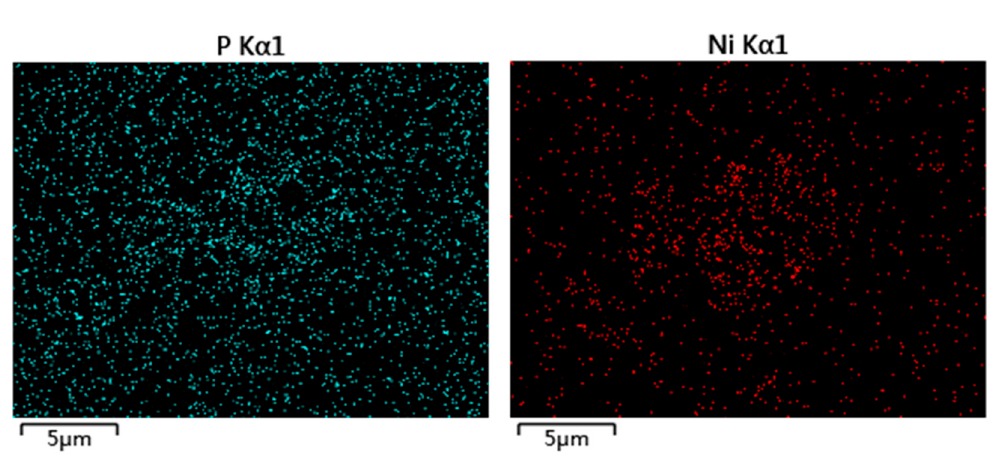
Figure 5. TEM micrographs of the samples: ( A ) NiP/H β calcined at 200 °C, ( B ) NiP/H β calcined at 300 °C, ( C ) NiP/H β calcined at 400 °C and ( D ) SAED picture of NiP/H β calcined at 400 °C.